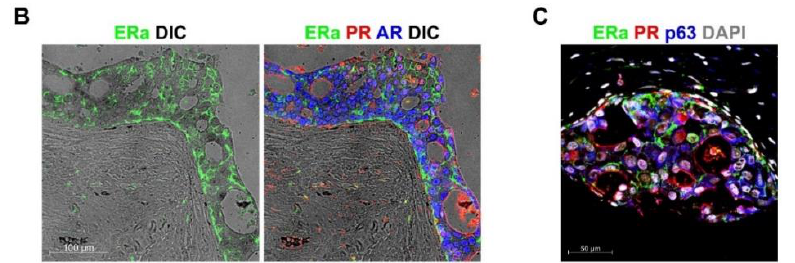
Figure 4. A breast cancer case diagnosed as triple negative presents plasma membrane ERa expression in ColNu mIHCF . BC5 is a case of ERa / PR-negative invasive ductal carcinoma with low HER2 positivity, and negative FISH. ( A , B ) In DCIS areas, ColNu mIHCF reveals epithelium with ERa located on the plasma membrane, strong nuclear AR with some PR colocalization, and PR also located on membrane regions not in contact with other epithelial cells. A basal layer of cells in contact with the stroma was strongly PR + . ( C ) Tumor cells also shows express p63. At the stroma, the most abundant population is PR + at a distance from the cancer ( A , B ) and p63 in the vicinity ( C ). The order of antibodies in the consecutive cycles is indicated above each photograph. Pseudocolor was kept constant: green for the 1st, red for the 2nd, and blue for the 3rd cycle. DAPI was included in the mounting medium and reveals the nuclei. DIC is a plane obtained with transillumination for di ff erential interfering contrast-Nomarski and reveals tissue structure.